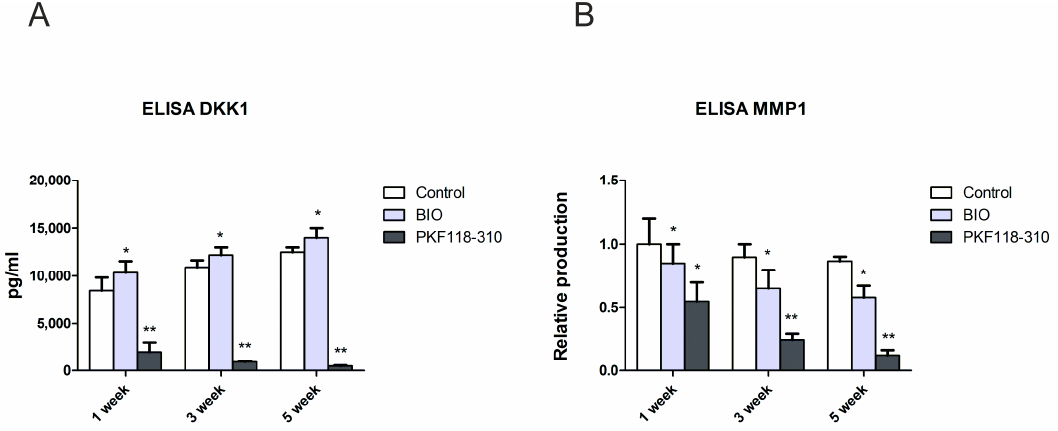
Figure 6. The protein concentration of DKK1 and MMP1 in the pellet culture medium. hMSCs pellets were treated with BIO or PKF for 5 weeks. The medium was collected in week 1, 3, and 5, respectively. The concentrations of DKK1 ( A ) and MMP1 ( B ) were measured by ELISA. * p < 0.05, ** p < 0.01. Error bars represent SD.